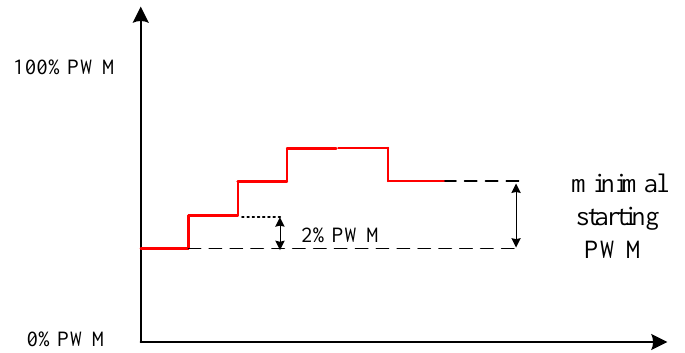
Figure 9. Minimum start PWM identification